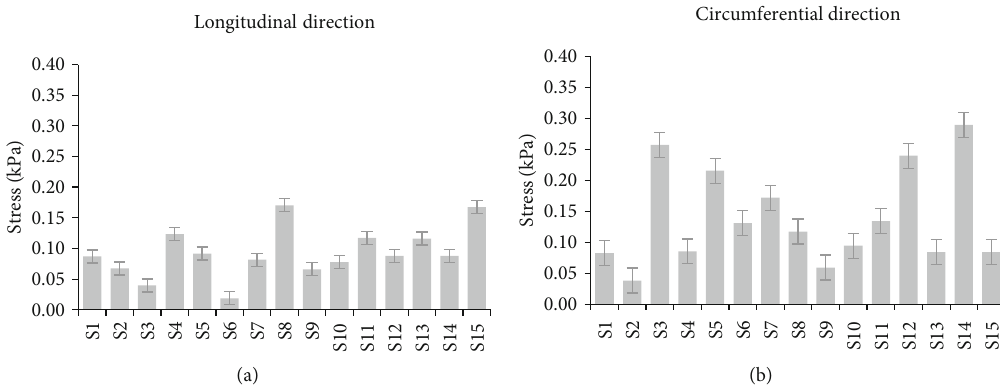
Figure 5: First Piola-Kirchhho ff stress (kPa) values taken at 15% engineering strain of the porcine soft tissue subjected to biaxial tension in two loading directions: (a) longitudinal and (b)